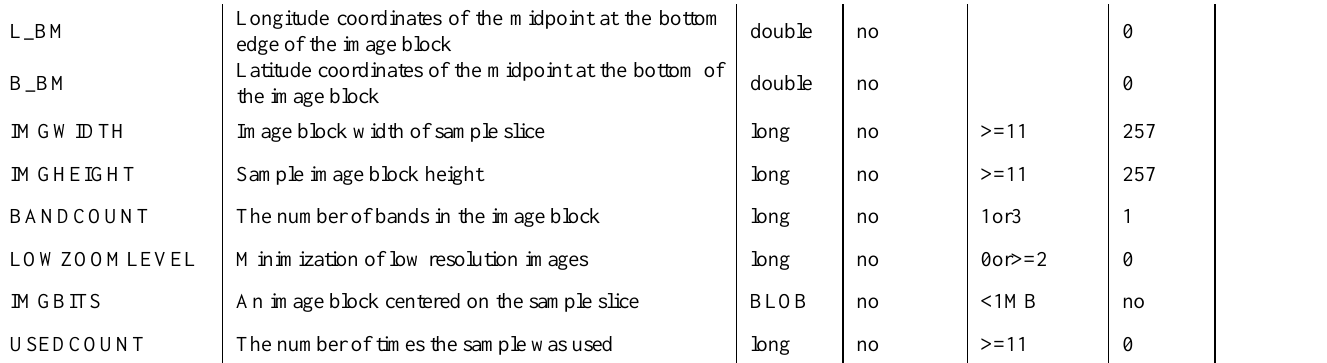
Table 1 Table of sample basic information